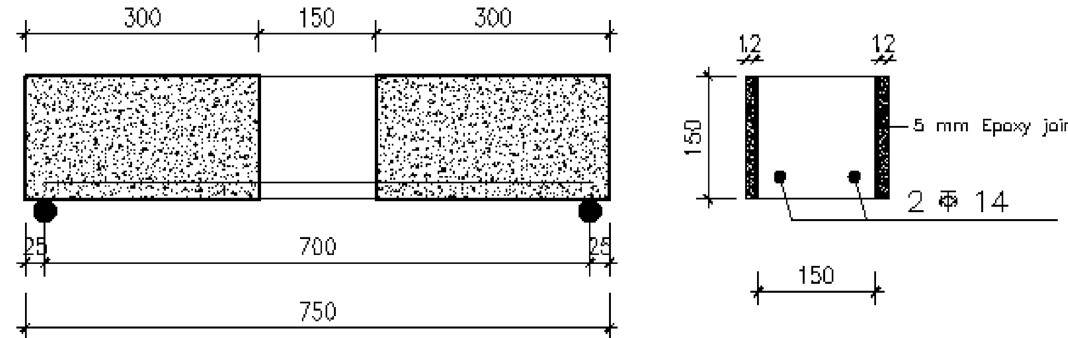
Fig. 5 RC beam strengthened with continuous HPFRC plates (All dimensions in mm)